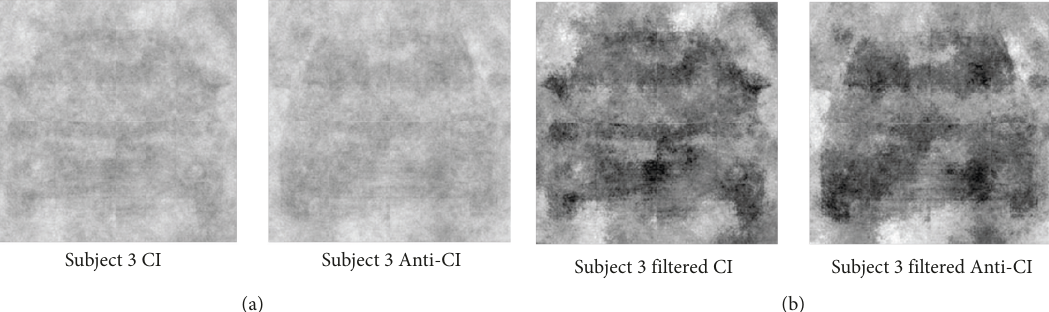
Figure 4: (a) Individual CI and anti-CI of subject 3 and (b) individual CI and anti-CI of subject 3 after the blur and shadow/highlight compensation filters were applied.